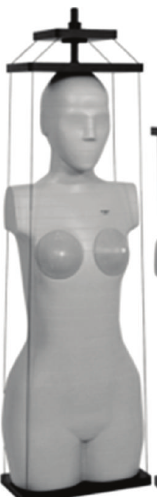
Figure 1: CIRS ATOM female phantom (Model number 702-D).